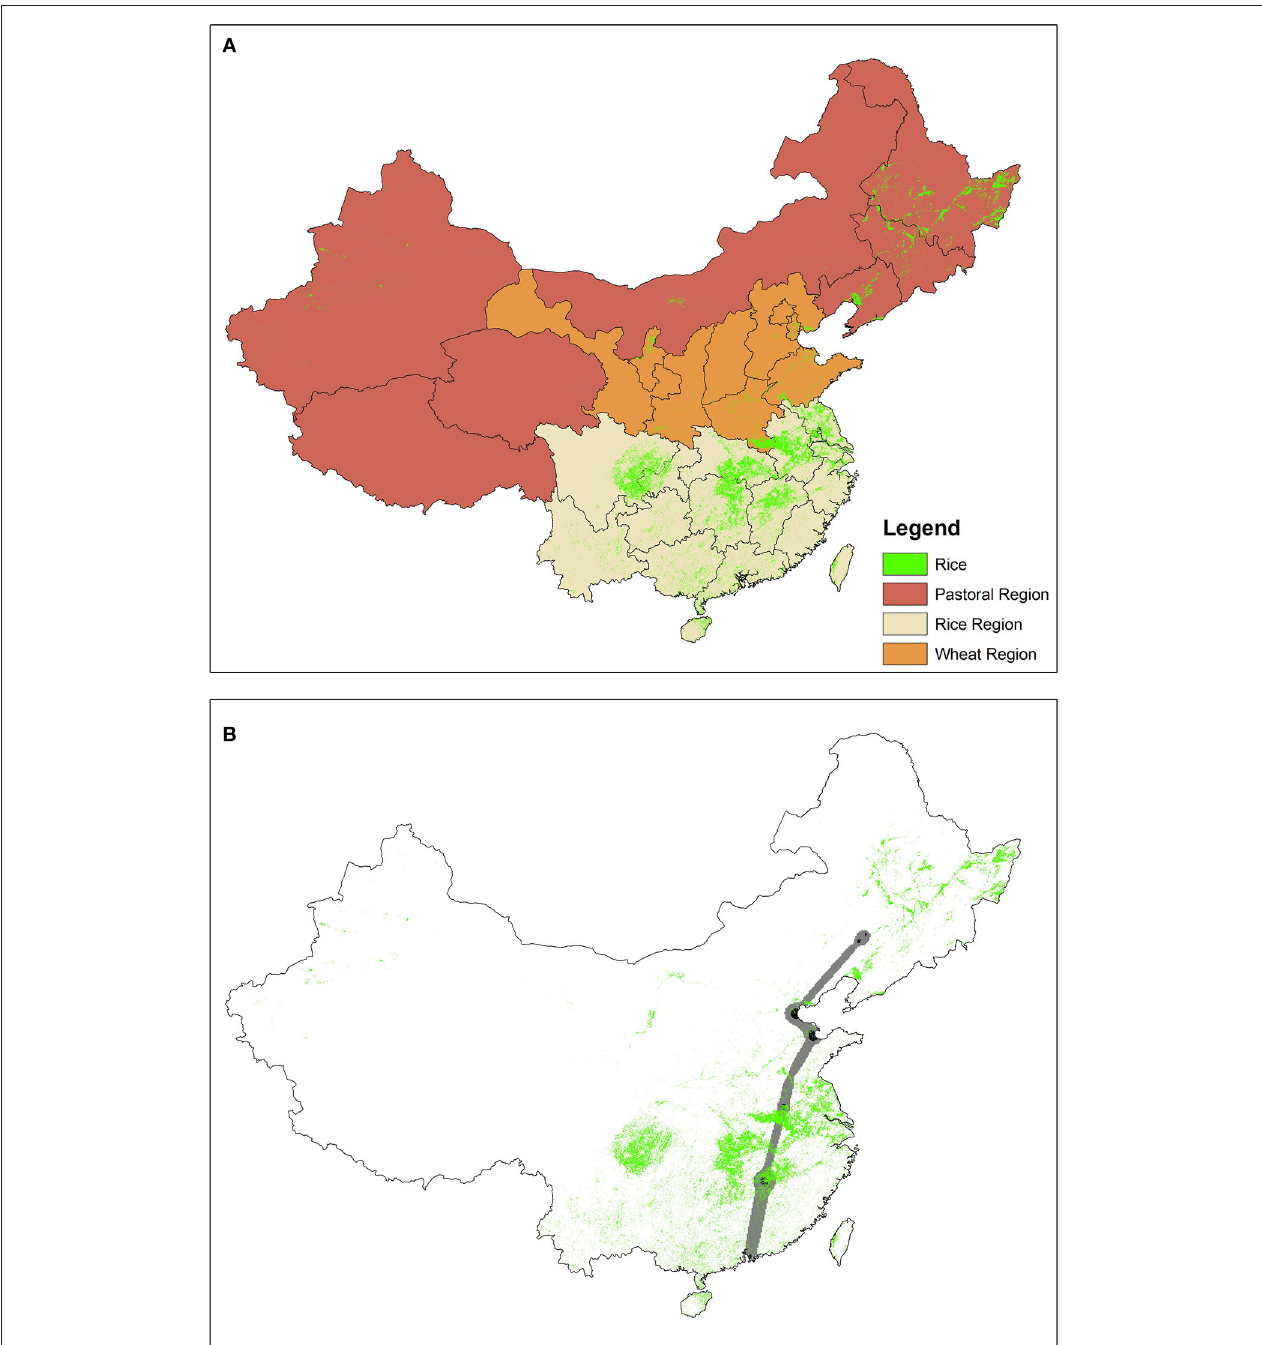
FIGURE 6 | Distribution of rice paddies across (A) China’s agricultural zones as defined by Pei et al. (2016), and (B) within the flight corridor (gray) and migration stopover areas (black) of Eurasian wigeon (PTT #44682) during spring migration. While only one individual is depicted in B, analyses were conducted for all individuals with complete spring migration tracks (6 Eurasian wigeon, 10 northern